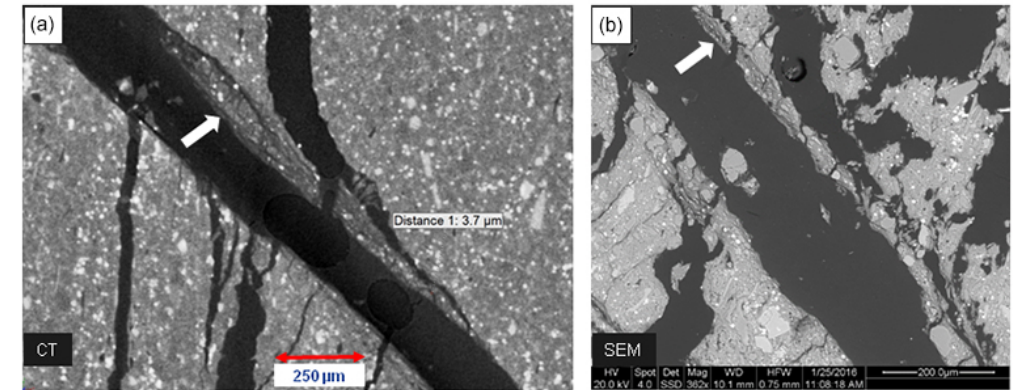
Figure 12. Magnified view of the shear failure from the X-ray CT image (a) and of the SEM image (b) .